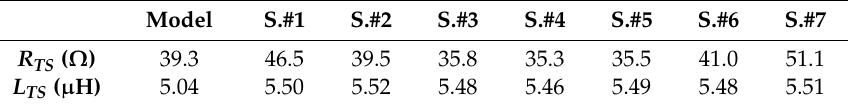
Table 3. Impedance of ink-jet printed flexible antenna dedicated to the HF band.